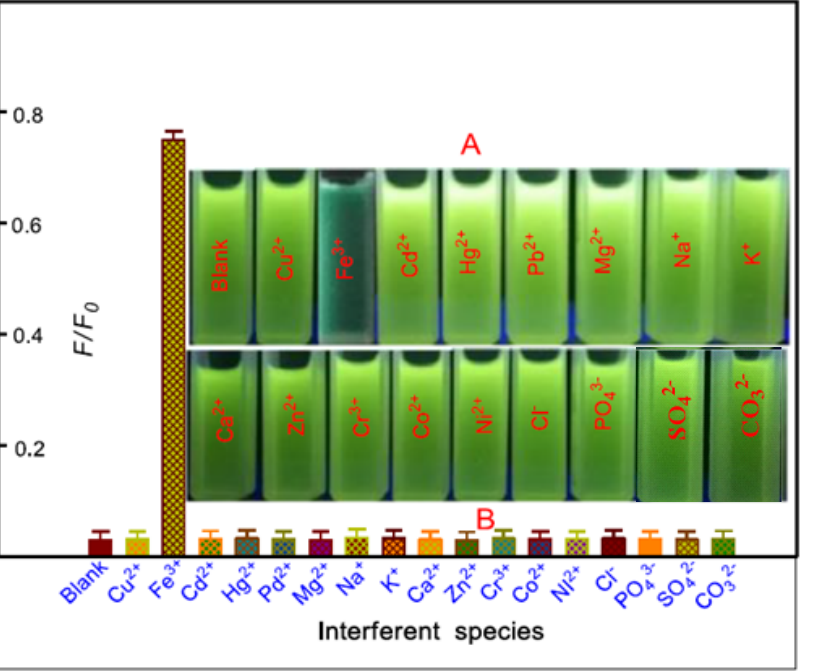
Figure 4. ( A ) Photographic image of fluorescence changes observed from the 2-APC solution in the presence of Fe 3+ and various potential interfering ions; ( B ) Fluorescence intensity changes of 2-APC caused by Fe 3+ in the presence of various interfering ions. The concentrations of 2-APC solutions were 10 µ M L − 1 . The error bars represent the standard deviations based on three independent meas- urements.